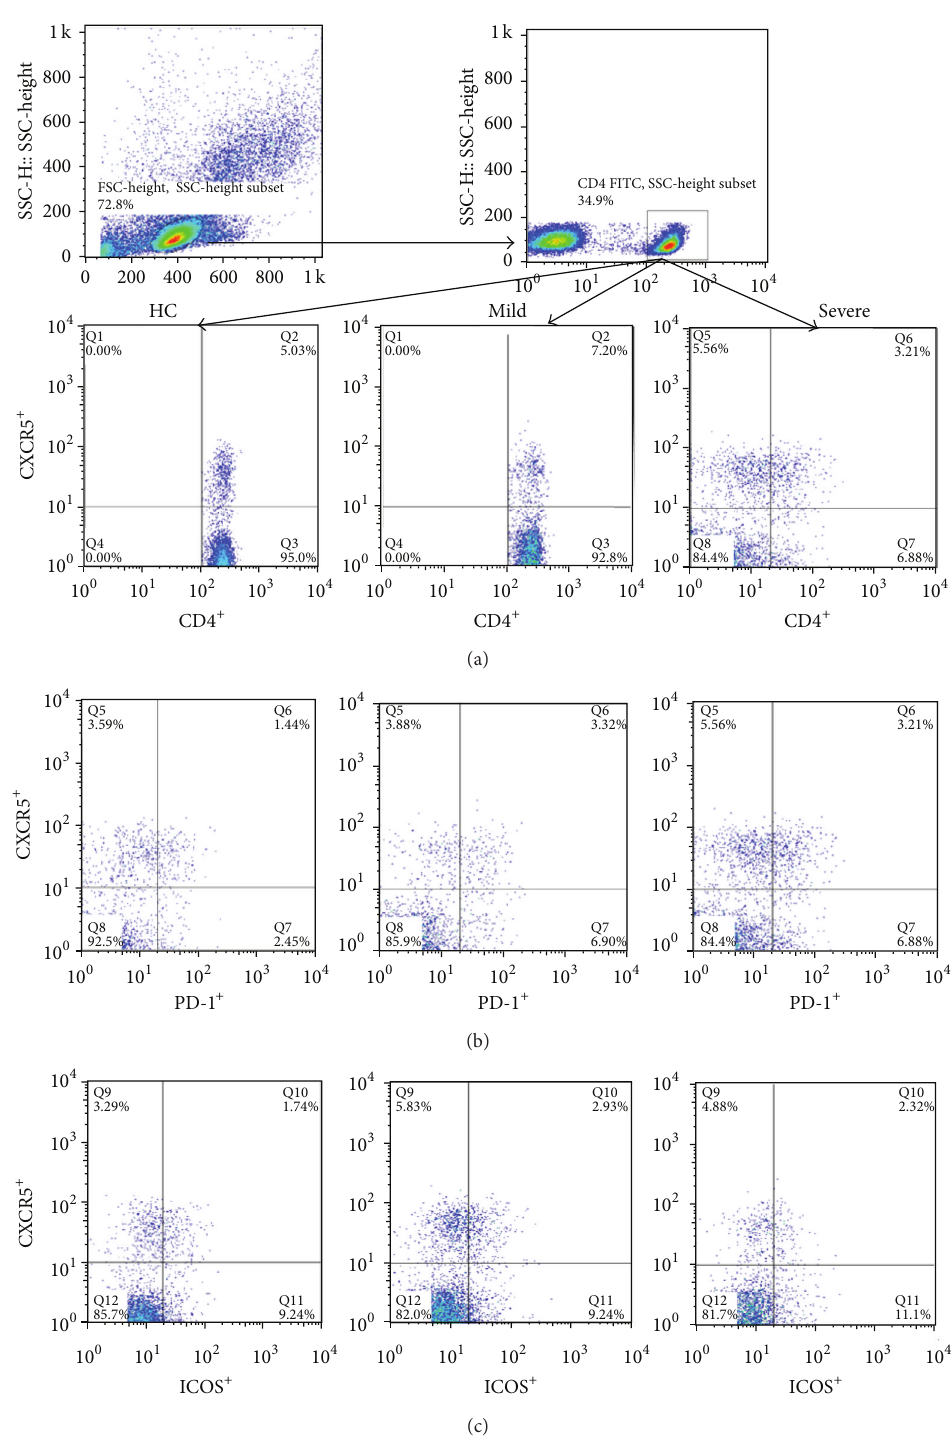
Figure 1: Detection of circulating CXCR5 + CD4 + TFH cells with ICOS high and PD- 1 high expression in peripheral blood of EV71-infected patientsandHC.Peripheralbloodmononuclearcells(PBMCs)frompatientswithEV71infectionandHCwerestainedwithlabeledantibodies and analyzed by flow cytometry as described in Section 2. The cells were gated initially on living lymphocytes (upper left) and then on CD4 + T cells (upper right). Representative plots of CXCR5 + CD4 + TFH cells in the total CD4 + T cells (a); PD- 1 high CXCR5 + CD4 + TFH cells (b); and COS high CXCR5 + CD4 + TFH cells